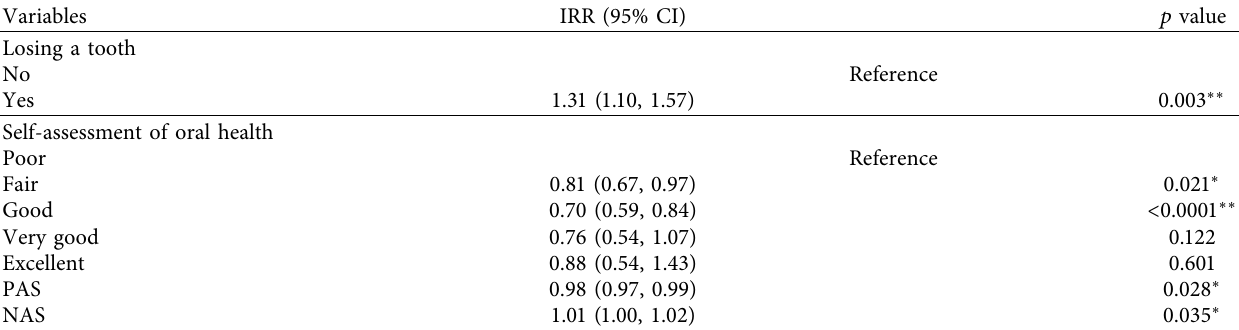
Table 4: Final modelling of OHIP-14 score based on associated variables using the backward method. Variables